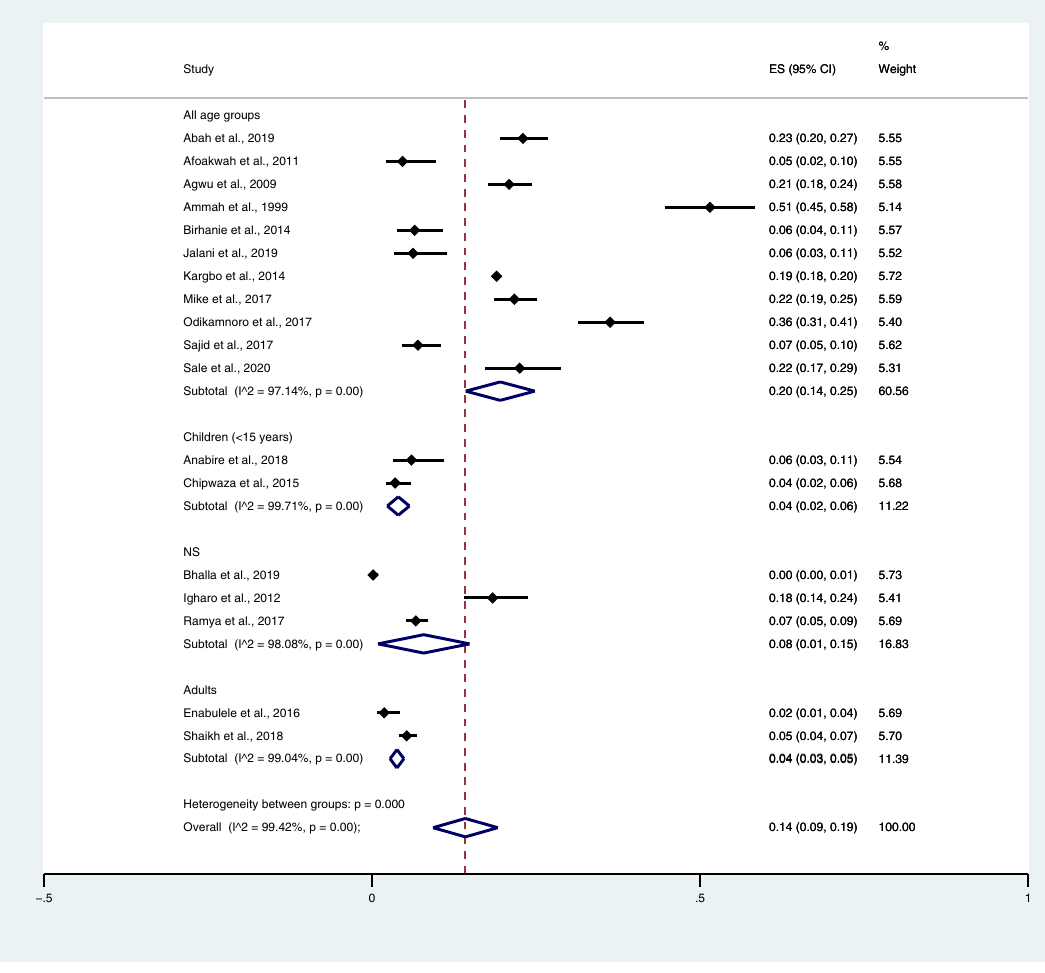
Figure 5. Pooled prevalence of typhoidal/NTS and malaria co-infection using the Widal test for the identification of Salmonella spp. infection stratified by age groups. ES proportion estimate (multiply 100 units for interpreted as prevalence estimate), CI confidence